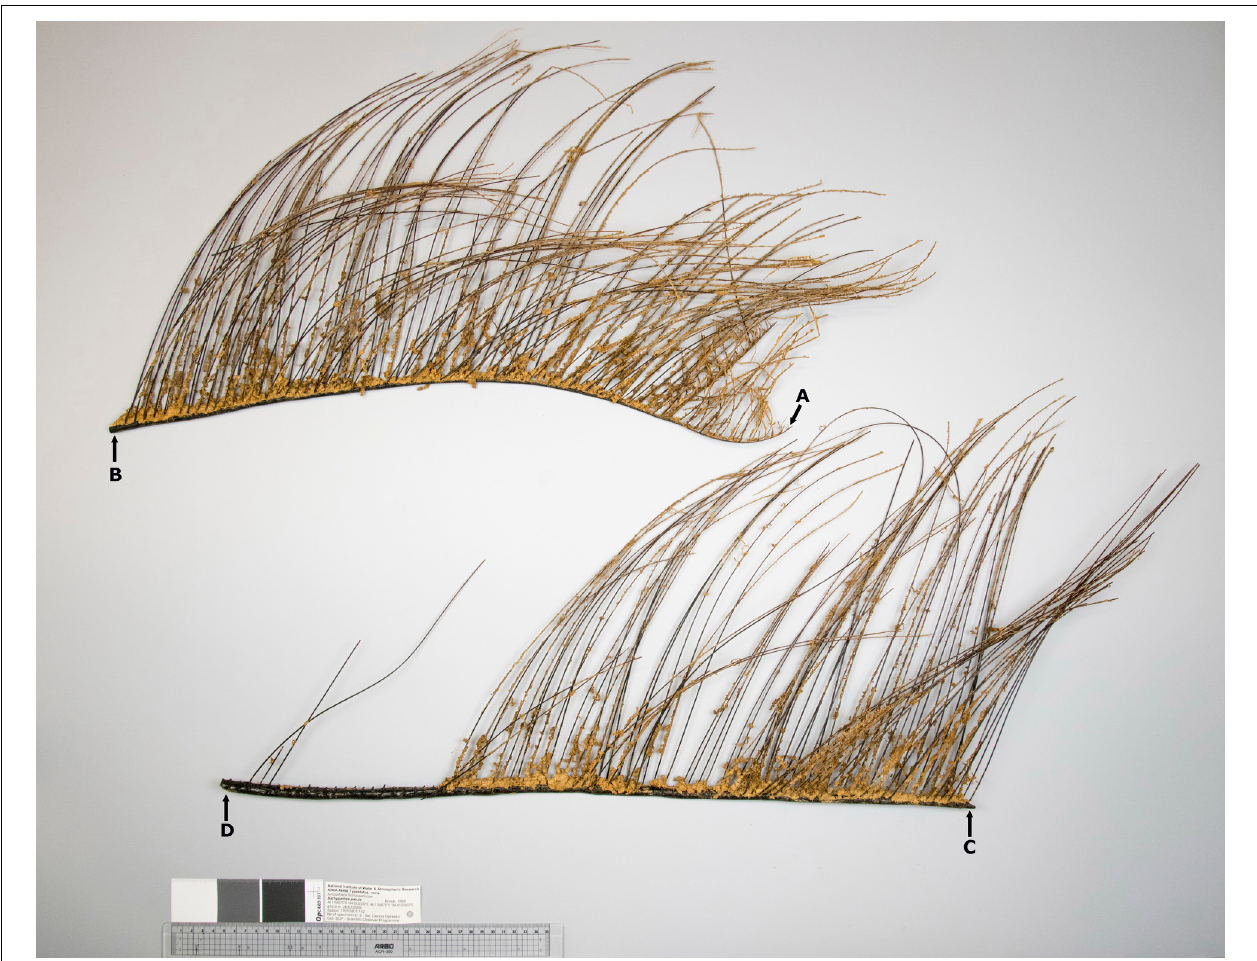
FIGURE 4 | Bathypathes patula NIWA49468. Specimen showing where samples were extracted for analysis. (A) is the growing tip, (D) the basal section, and (B,C) are intermediate sample sites as the specimen was broken on collection and an unknown length of the main branch stem may be missing from between these two sites. Specimen from Chatham Rise, New Zealand. Scale bar is a 35 cm